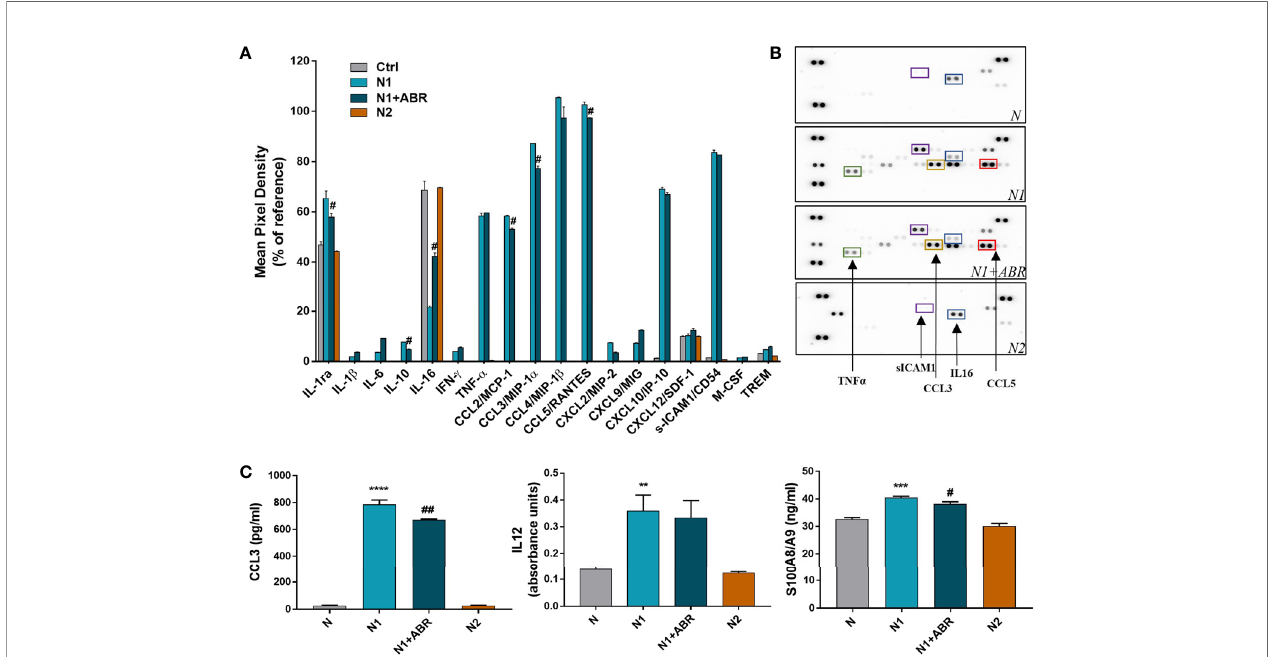
FIGURE 4 | Effects of S100A9 blockade on neutrophil mediators released in the conditioned media after 18h of culture. (A) Quanti fi cation of mediators present in the culture medium from N1, N1 treated with ABR-23901, and N2 neutrophils compared to control neutrophils (N), as detected by the Proteome Pro fi ler mouse cytokine array. The culture medium was pooled from three experiments. Protein levels were normalized to references on each membrane. # p < 0.05 (N1+ABR versus N1 neutrophils). (B) Representative membranes incubated with the condition media from N, N1, N1+ABR and N2 neutrophils. (C) Measurement of CCL3, IL-12 and S100A8/A9 in the neutrophil s condition media by ELISA. The data represent mean ± SD from three experiments; **p < 0.01, ***p < 0.001, ****p < 0.0001 (N1 vs N); # p < 0.05; ## p < 0.01 (N1+ABR versus